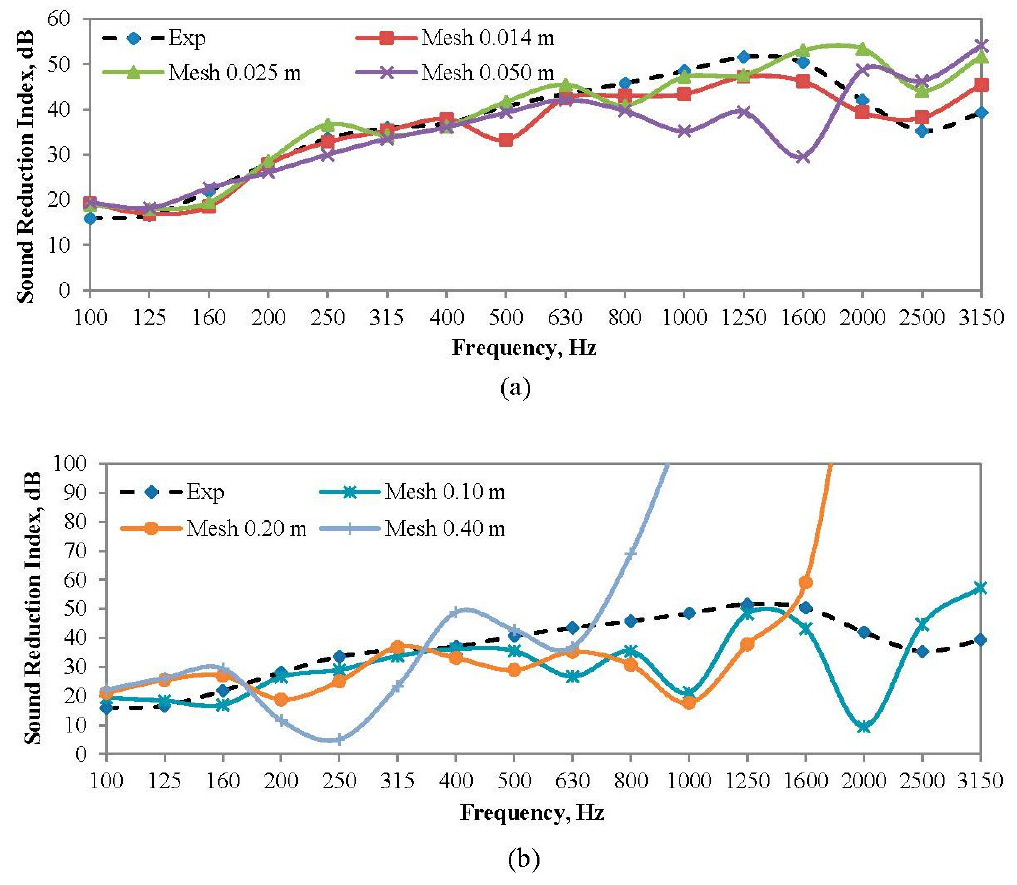
Figure 7. Comparison of Sound Reduction Index at one-third-octave bands for various mesh sizes, ( a ) 0.014–0.050 m and ( b ) 0.10–0.40